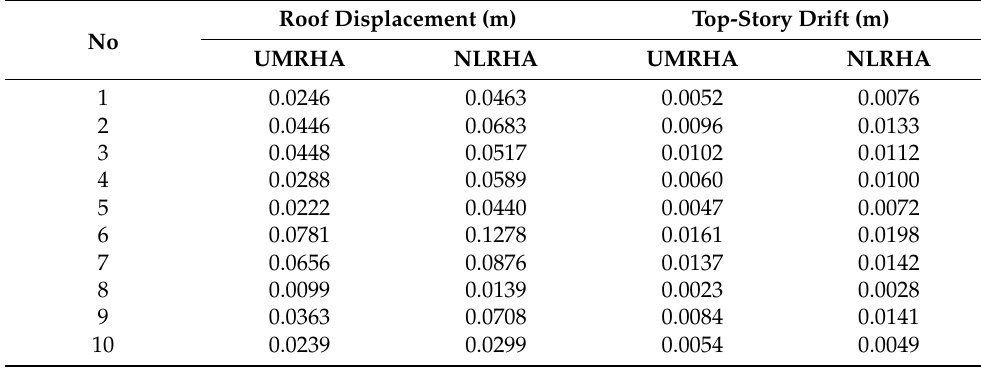
Table 8. Peak values regarding roof displacement and top-story drift of RES bare frame.